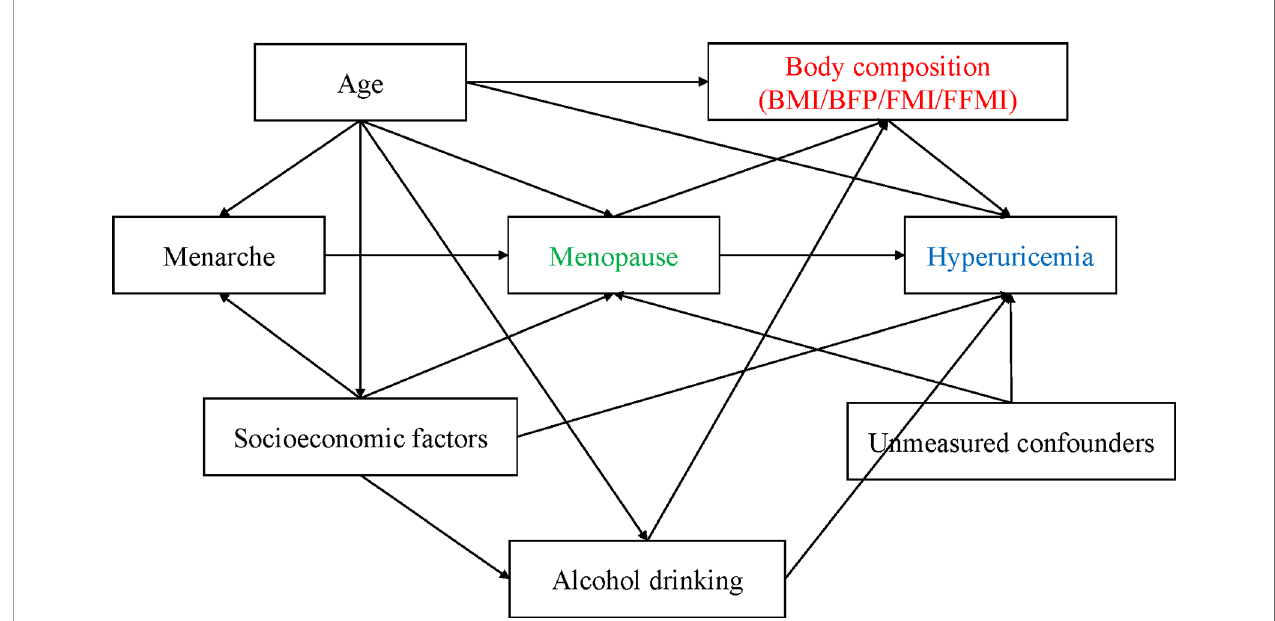
FIGURE 1 | The relationships between covariates and hyperuricemia demonstrating by directed acyclic graph